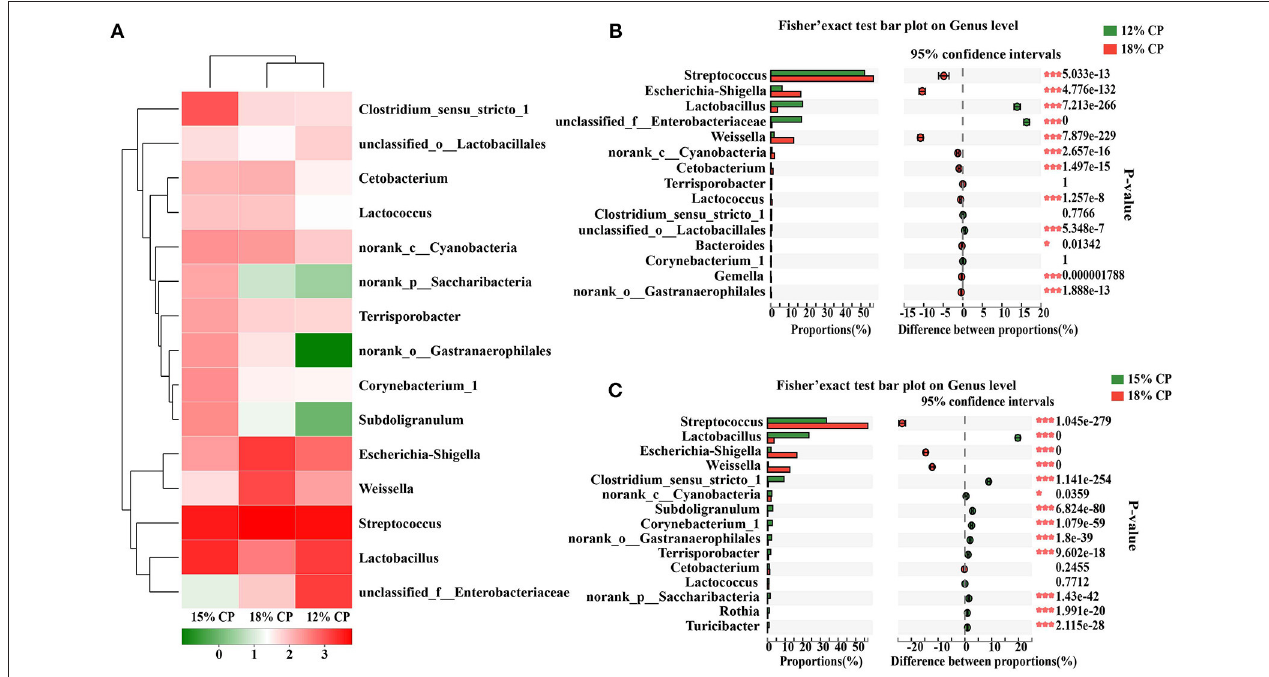
FIGURE 2 | Effects of low-protein diets on the composition of ileal microbiota in growing pigs at the genus level. (A) Distribution of the top 15 ileal bacteria at the genus level. (B) Fisher’ exact test bar plot on the genus level between the top 15 ileal bacteria of the 12 and 18% CP groups. (C) Fisher’ exact test bar plot on the genus level between the top 15 ileal bacteria of the 15 and 18% CP